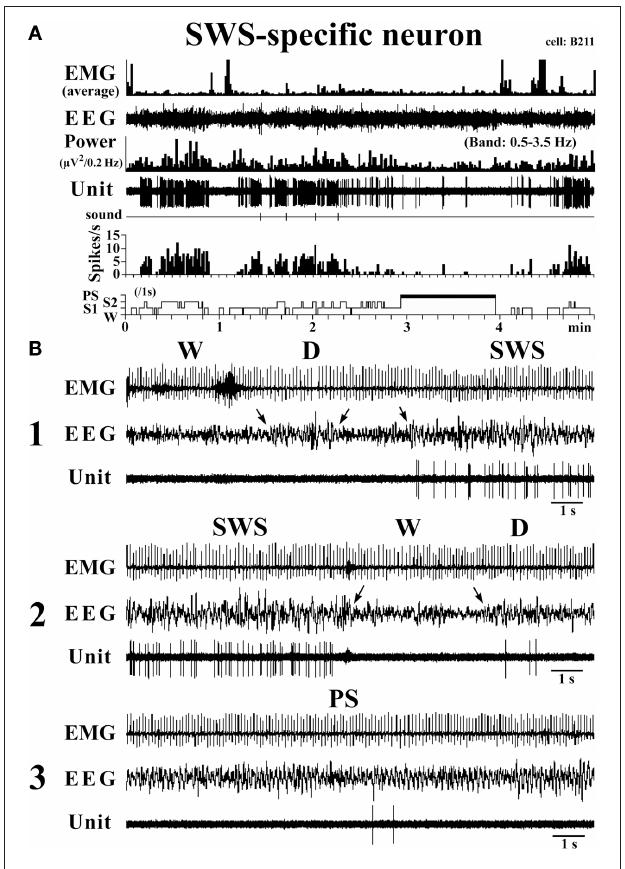
Figure 5 | Activity of a VTM SWS-specific neuron across the sleep- waking states. The arrows indicate the state transitions. The three traces in (B) are from the periods seen in (A) .